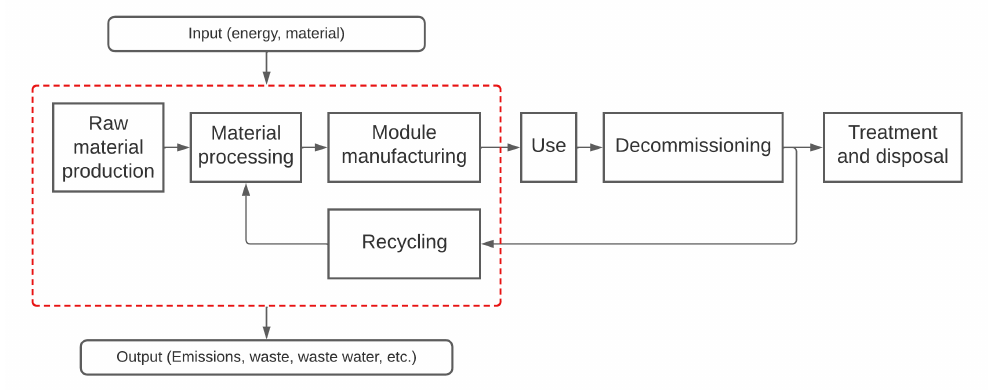
Figure 3. Simplified life cycle of PV